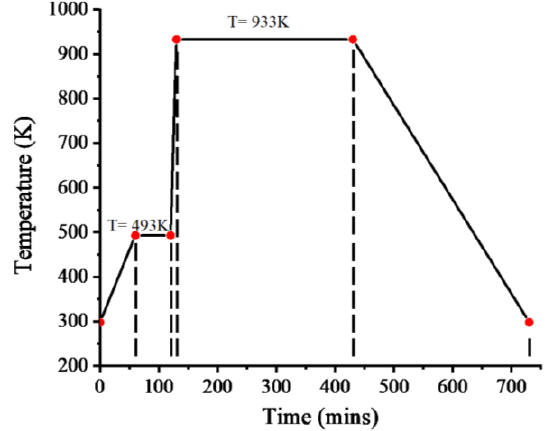
Figure 3. Heat treatment experiment condition (temperature and time).